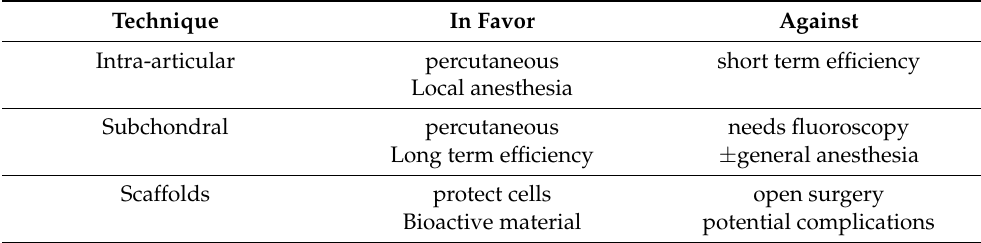
Table 4. Pros and Cons of different arguments in BMAC administration. Technique In Favor